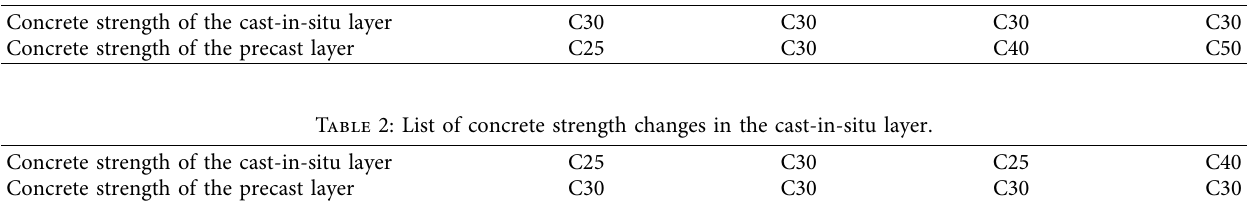
Table 1: Change in the concrete strength of the precast layer.